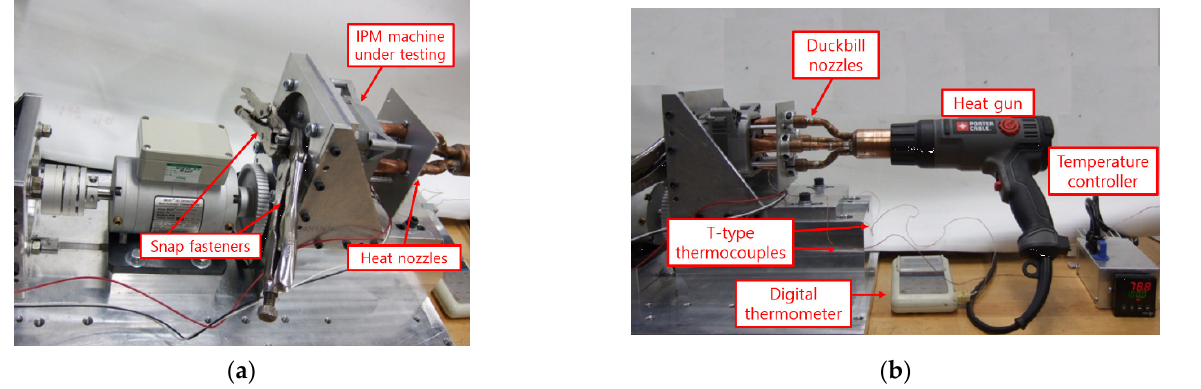
Figure 9. Dynamometer test configuration: ( a ) locked-rotor test setup; ( b ) heat gun with duckbill nozzles for temperature